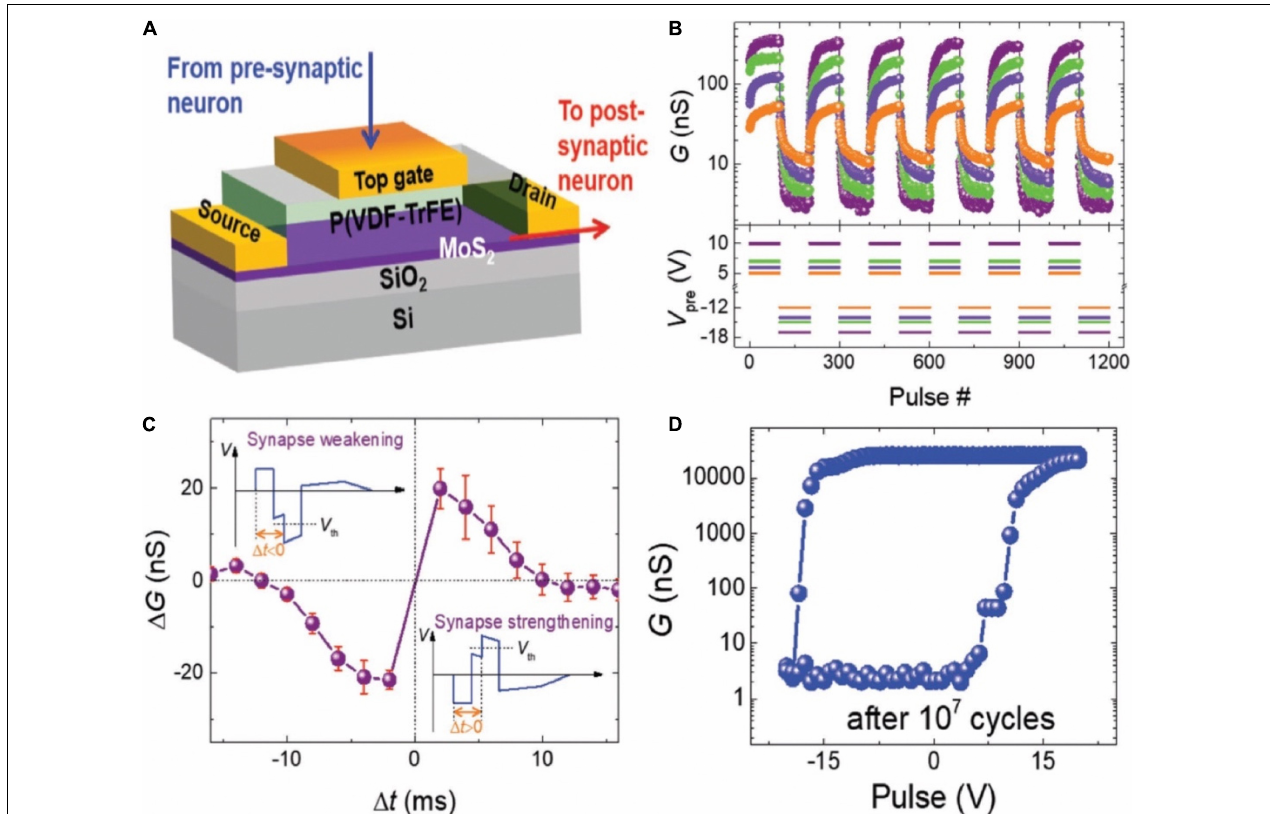
FIGURE 6 | (A) Schematic diagram of the organic ferroelectric synaptic device. (B) Change of the channel conductance with the different voltage pulse sequences. (C) Measurement of STDP in the transistor. (D) Change of the channel conductance with various gate voltage pulse amplitude after 10 7 cycles of total polarization switching (adapted from Tian et al.,